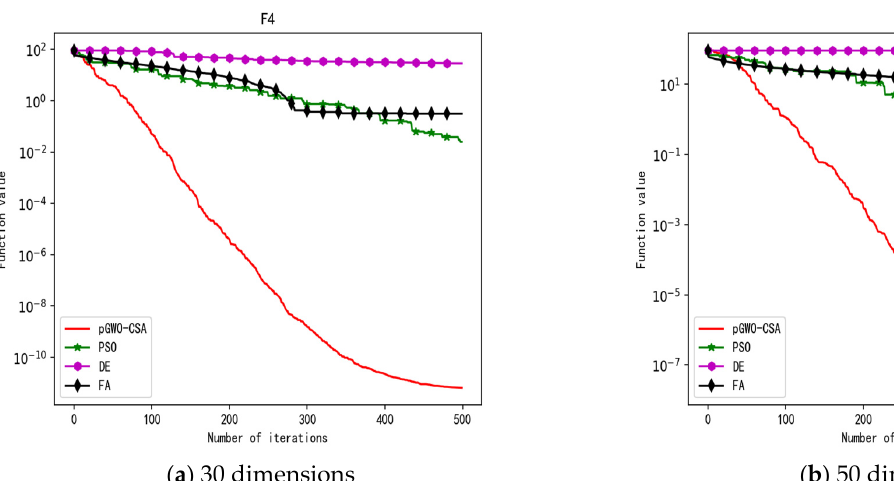
Figure 8. Convergence curve of test function